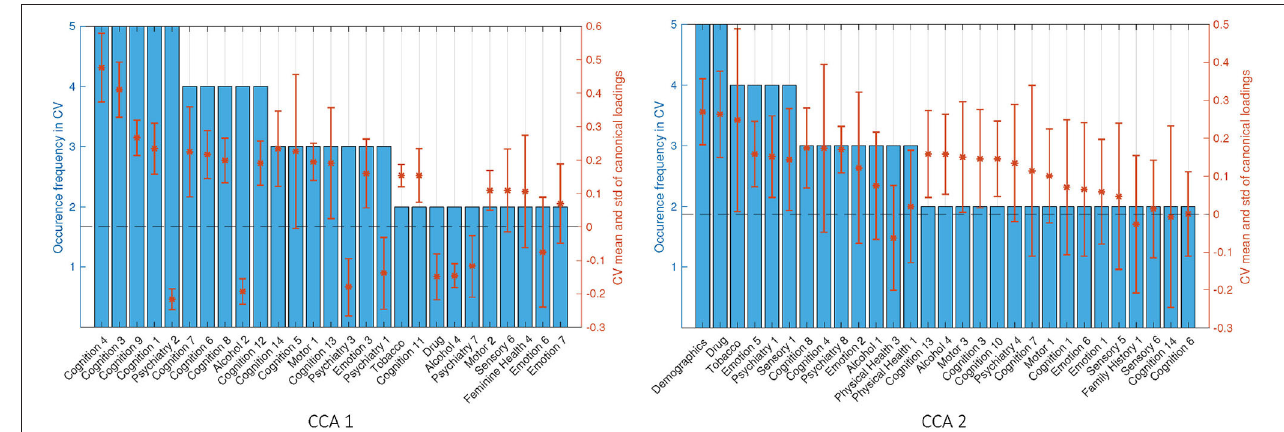
FIGURE 8 | Stability of SM canonical loadings on CCA input. The bar plot shows the occurrence frequency in CV out of the five-folds. Variables are chosen by selecting the top 20 mostly weighted ones in each fold. The ones that appeared at least two times are shown above. The right axis shows the mean and the SD over all occurred loadings. Left and right plots are the canonical loadings for the first and second canonical variables,